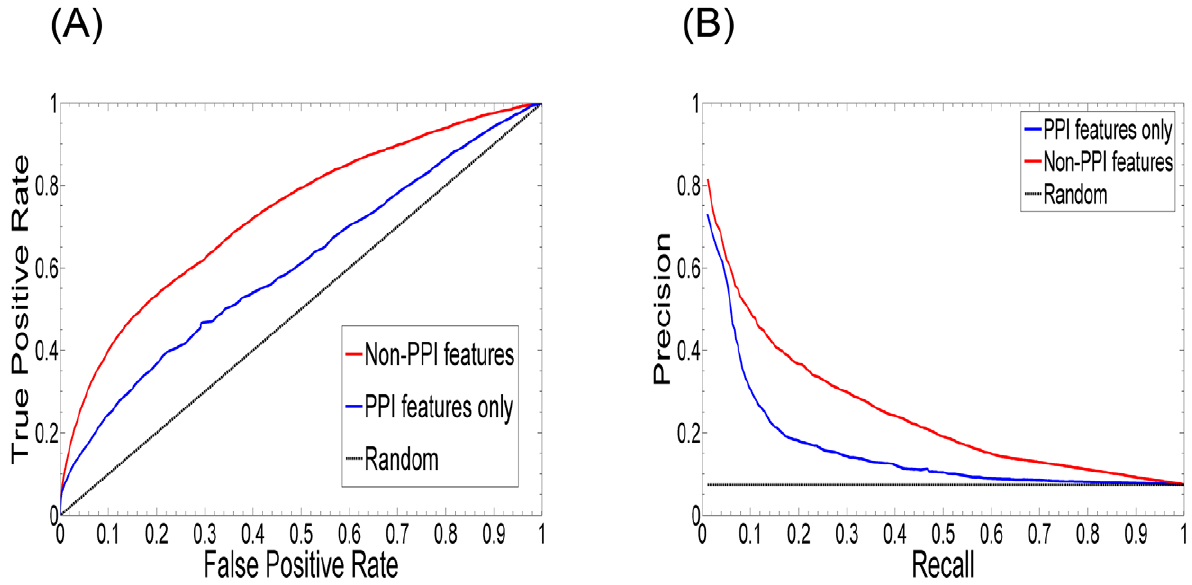
Figure 6. The performance of PPI-only and non-PPI features for predicting genetic interactions. In this experiment, we split our 152 SL- independent features into two sets: (1) the set of PPI-only features which are derived only from the PPI network and (2) the set of non-PPI features which don’t involve the PPI network. The two feature sets were then used to train and test our multi-classifier on our SGD-SL data set. (A) ROC curves of our ensemble based on the PPI-only (AUC=0.605) and non-PPI (AUC=0.731) feature sets. (B) Precision-recall curves of our ensemble based on the PPI-only and non-PPI feature sets. The corresponding ROC and precision-recall curves for a random classifier are also shown. doi:10.1371/journal.pcbi.1000928.g006 PLoS Computational Biology |